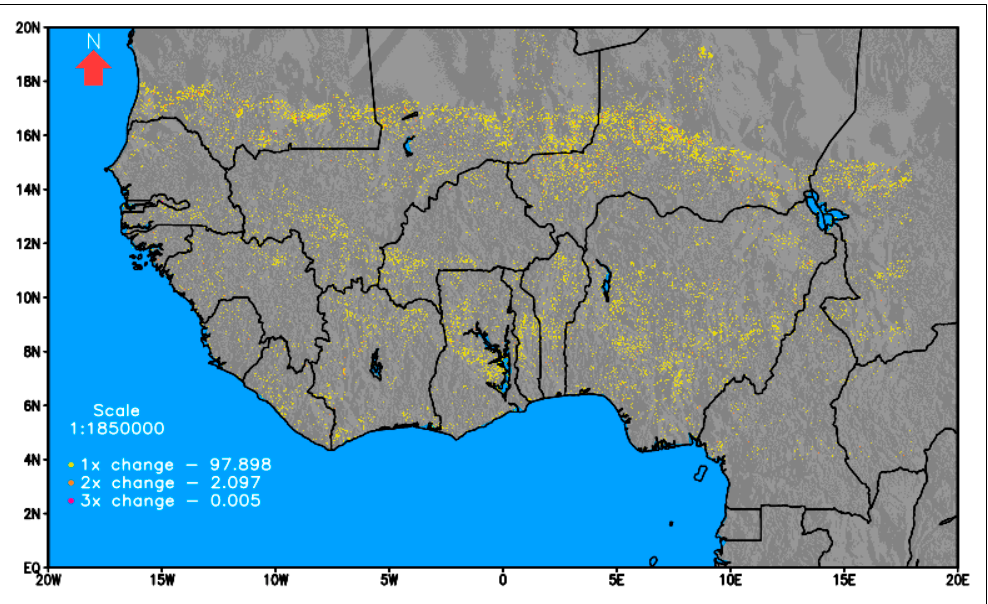
Figure 3. ESA CCI LC changed pixels between 1992 and 2019 categorised by frequency of change.